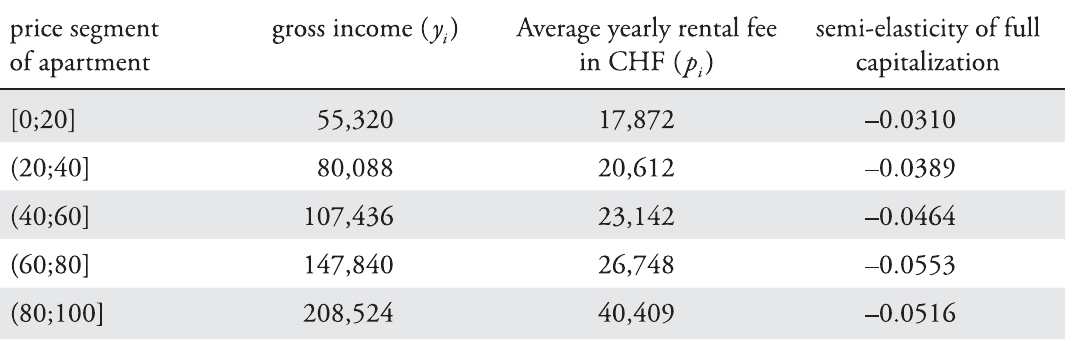
Table 5: Conversion of Semi-Elasticity Measures into Capitalization Rate